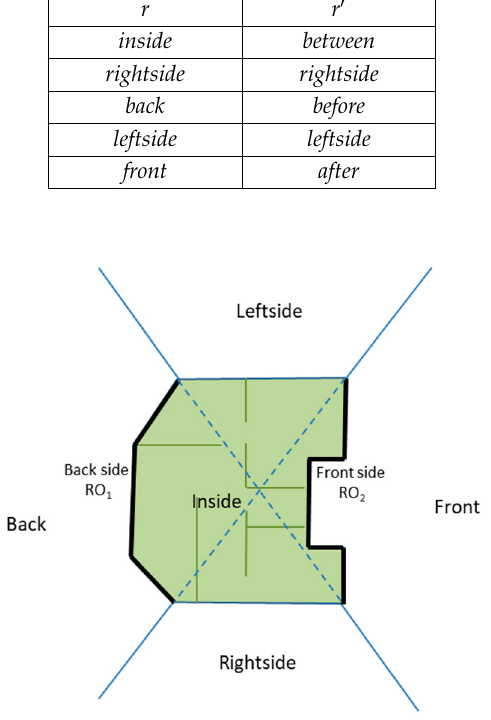
Figure 5. Geometric frame of reference .